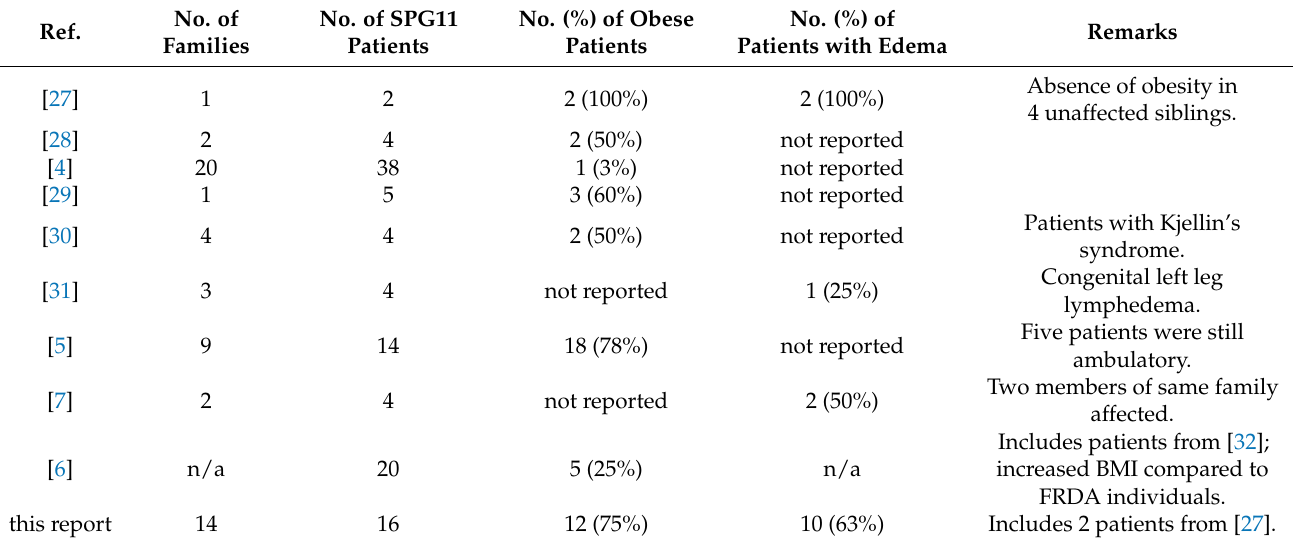
Table 3. Obesity and lymphedema in previous case series of